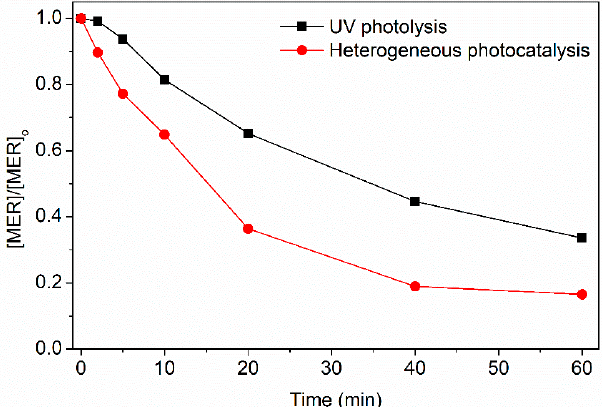
Figure 3. Variation of the MER concentration due to UV photolysis and heterogeneous photocatalysis with the TiO 2 /fiberglass substrate ([MER] o = 100 mg/L, pH = 5.7).